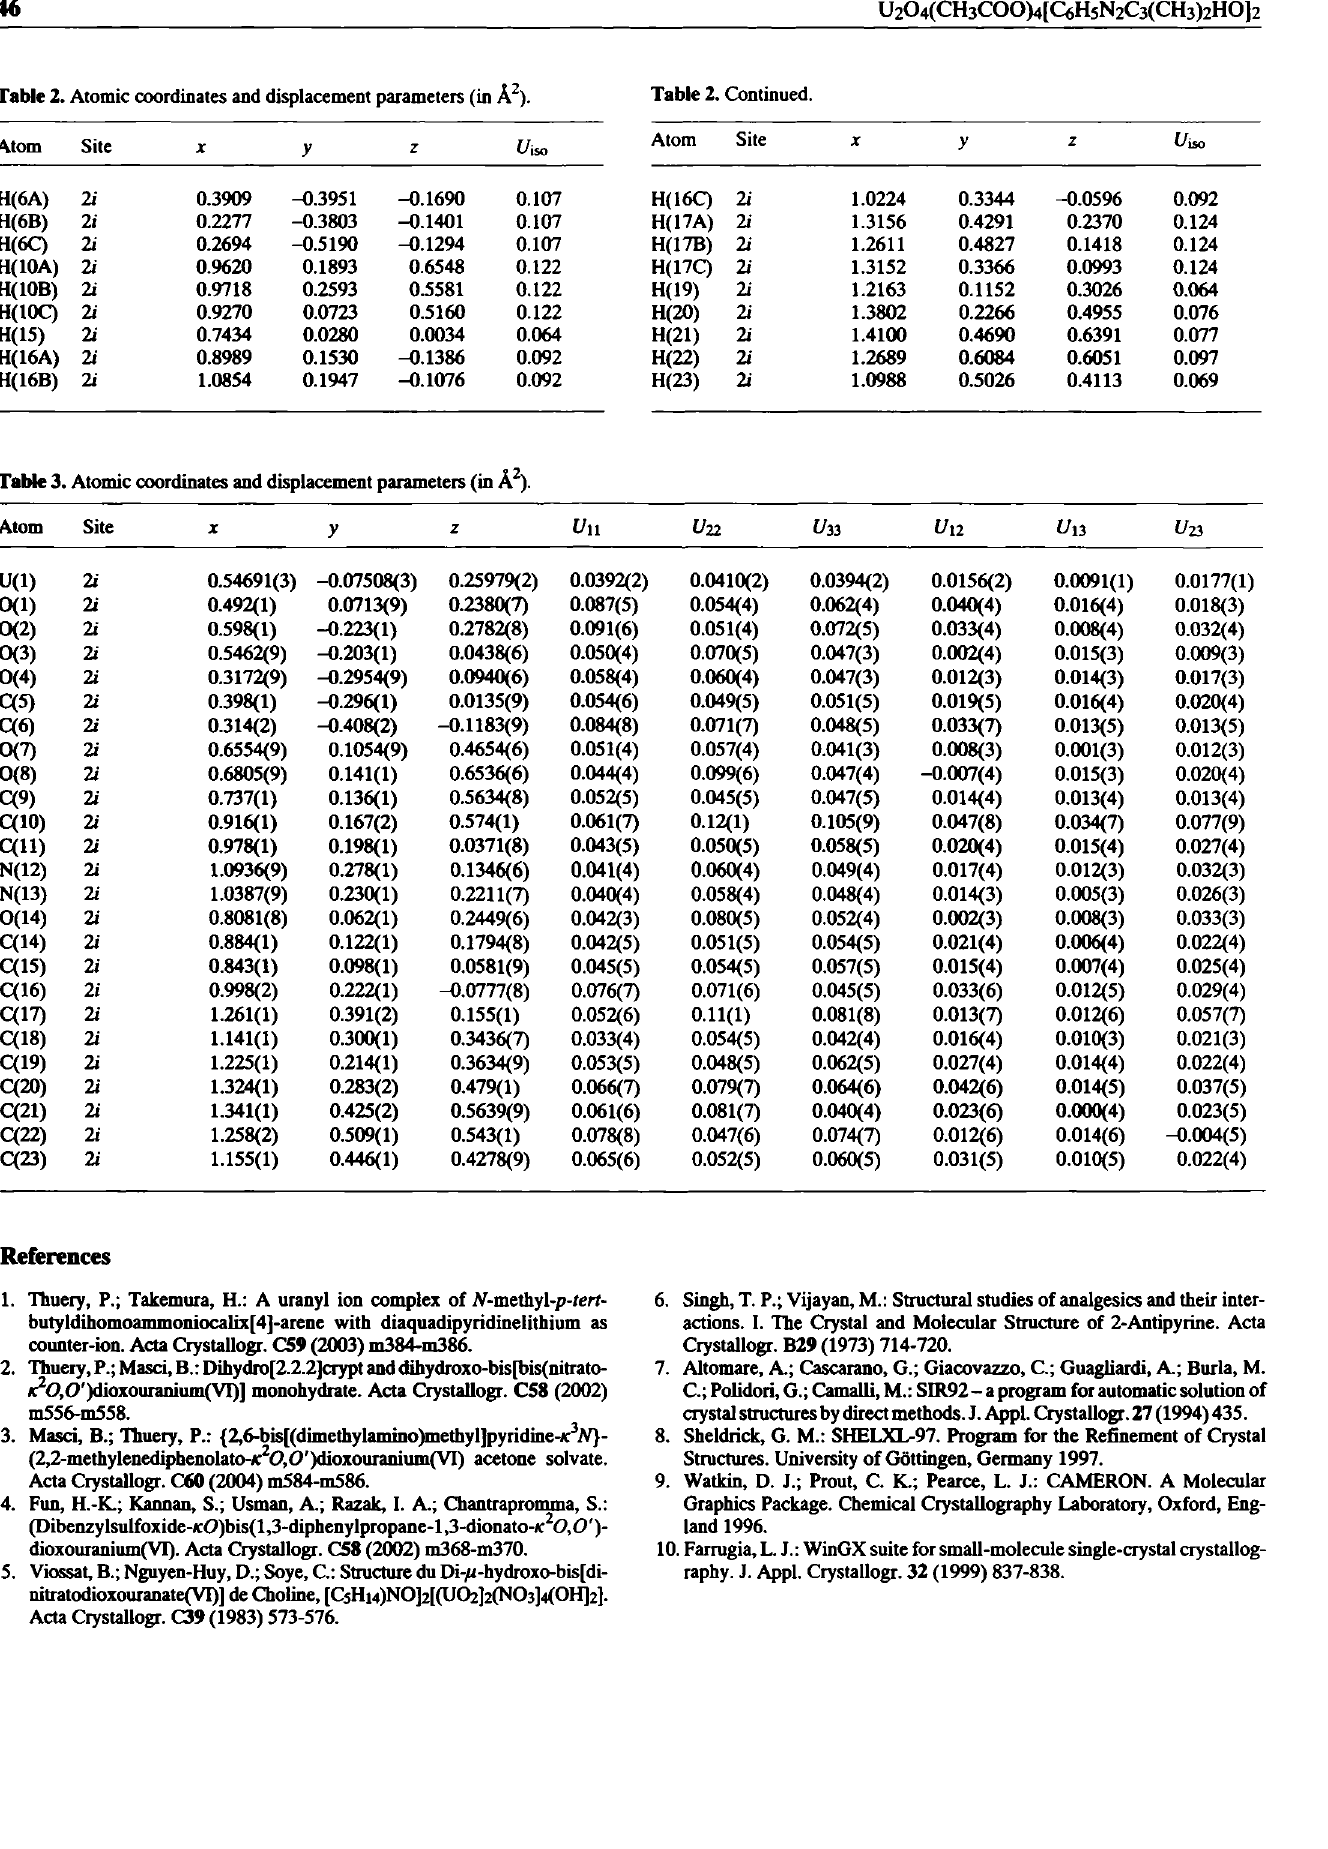
Table 3. Atomic coordinates and displacement parameters (in Ä 2